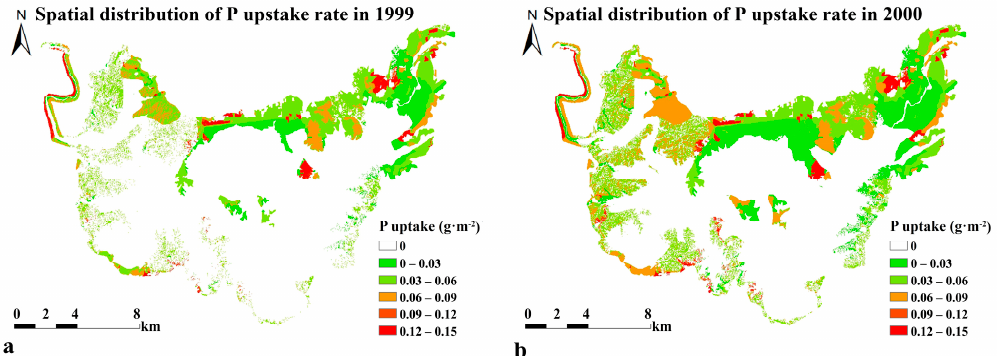
Figure 5. Spatial distribution of the N uptake rate in Miyun’s inner protection zone during different years.